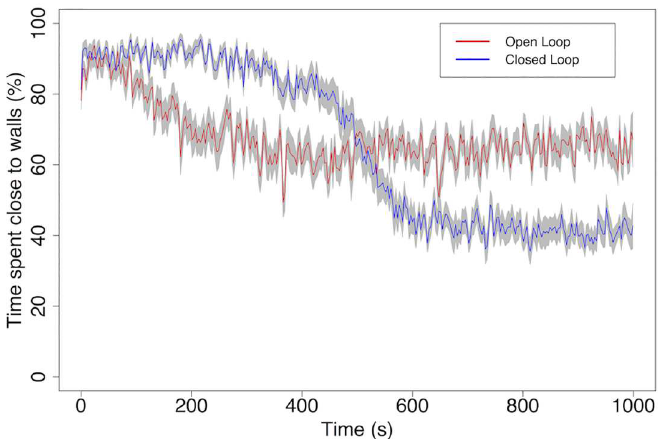
Fig 10. Learning curves of the wall avoidance task. The robot is consideredto be “close” to a wall if it is less than 80 pixels from the wall, which corresponds to the range of its distancesensors. The results show that random steering due to high random activity in the network leads to spending 64% of the time close to walls, whilelearningdue to LSA leads to only 43% time spent close to walls. Statistical results for N = 20 networks, standard error is